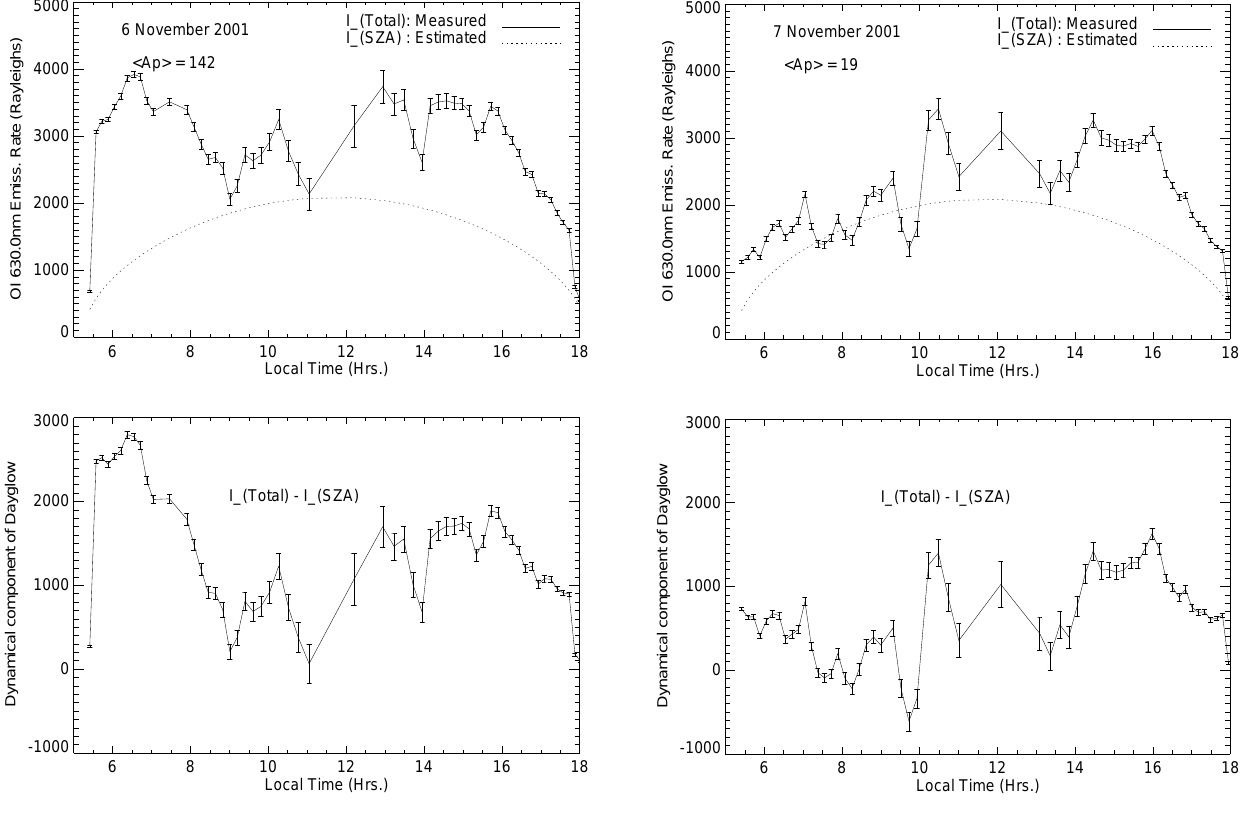
Fig. 3. Same as in Fig. 2 but for 6 November 2001. Notice the rise in emissions in the morning above the dotted line (SZA vari- ation), which is approximately equal to the typical afternoon peak emissions and a factor of 2–3 increase when compared with the morning quiet time emissions (see Fig. 5). The SZA variation used for this day is the same as the one used for all three days. The increase in emissions in the dynamical component in the morning 05:30–08:30 LT (bottom panel) is 4–5 times larger than the typical dynamical variations on a quiet day (see Fig. 5). This brightening is interpreted to be due to the changes in neutral composition over low latitudes. These changes are brought about by neutral winds from high latitudes and TAD triggered by the magnetic storm.